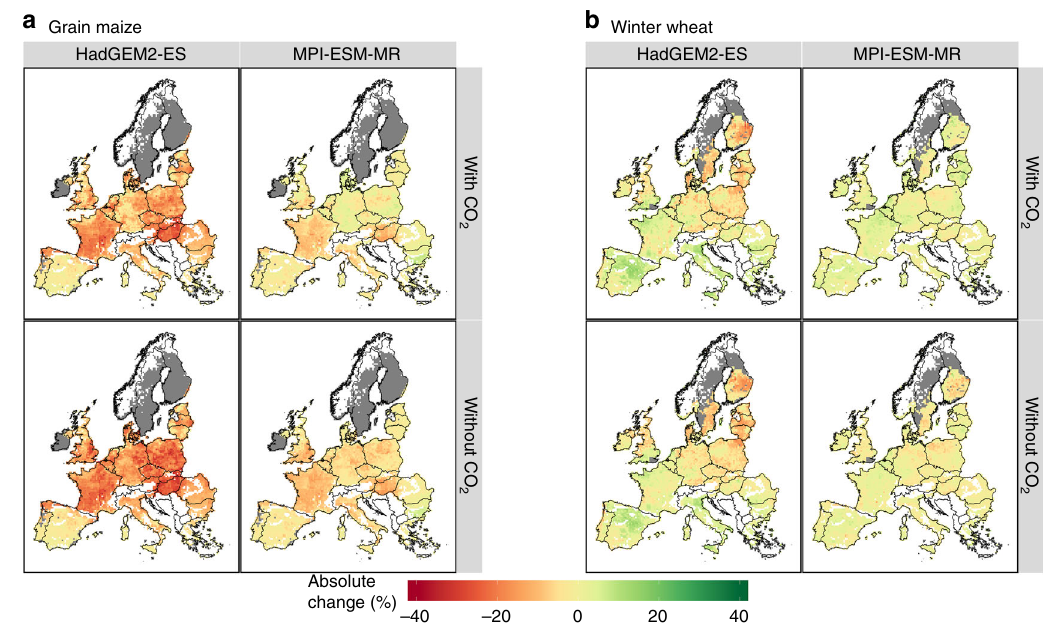
Fig. 5 Change in yield losses due to drought. Change in yield losses due to drought in a grain maize and b winter wheat for 2040 – 2069 for RCP4.5 relative to the baseline period (1981 – 2010). Results are presented with (top row) and without (bottom row) consideration of CO 2 fertilization effects and